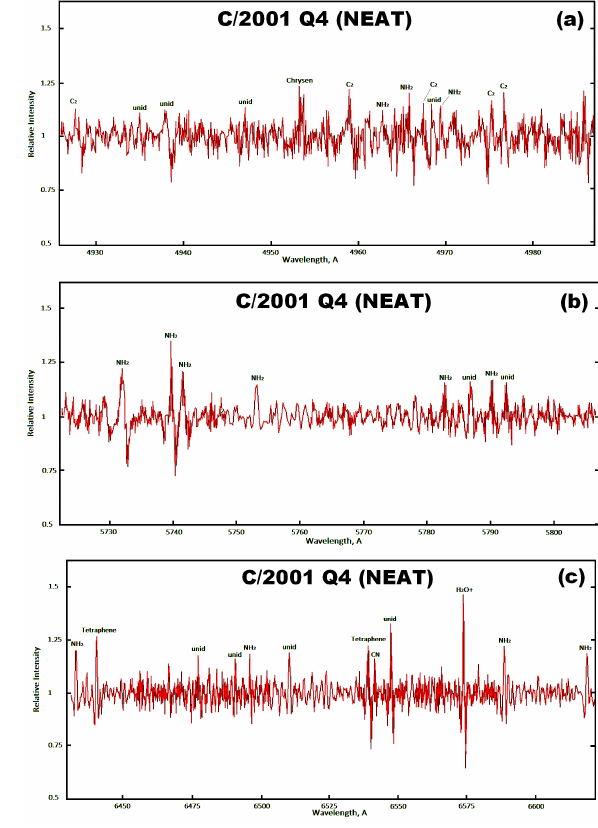
Figure 1. Three fragments of 40 th spectral order of normalized echelle spectrum of C/1999 S4 (LINEAR) with the continuum re- moved and solar spectrum extracted.